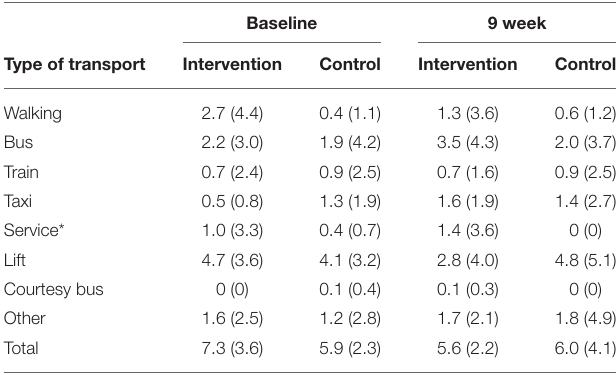
TABLE 3 | Use of transport methods to leave the home M (SD) over a 7-day period at the end of Phase